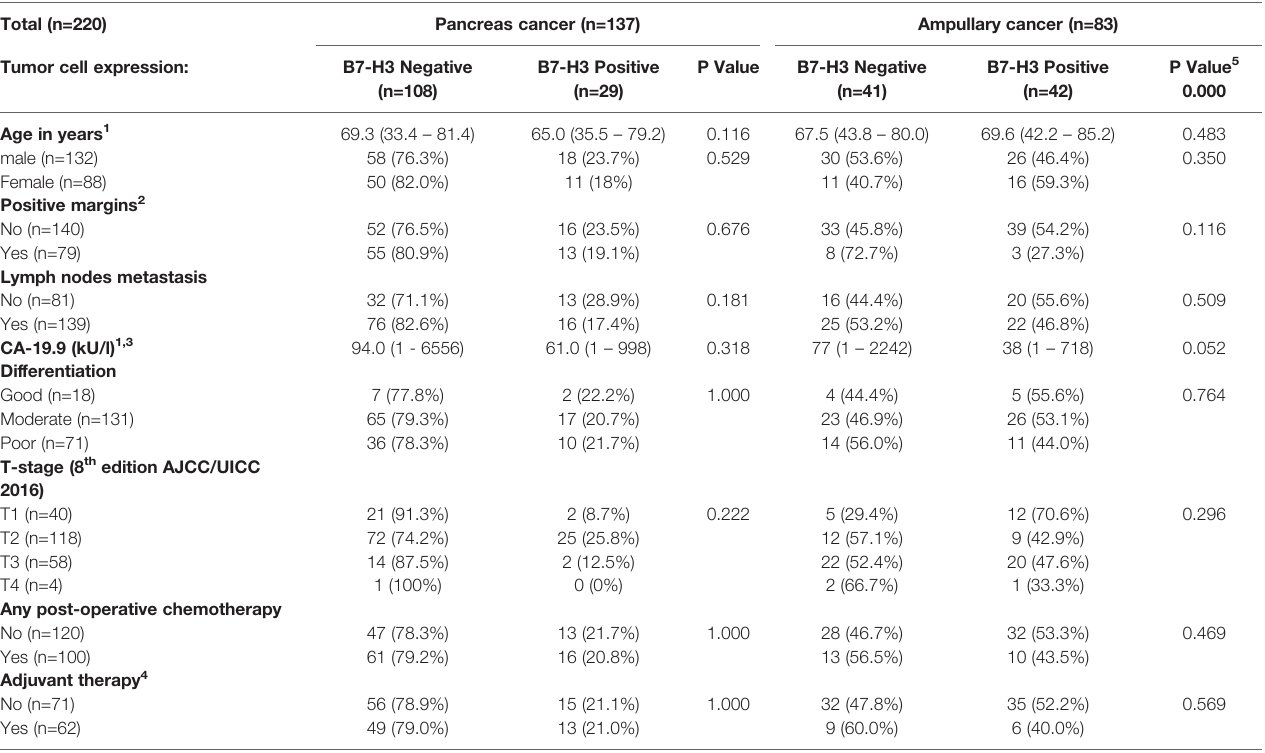
TABLE 1 | Cancer cell expression of B7-H3 and baseline characteristics of pancreatic cancer and ampullary cancer patients. Total (n=220) Pancreas cancer (n=137) Tumor cell expression: